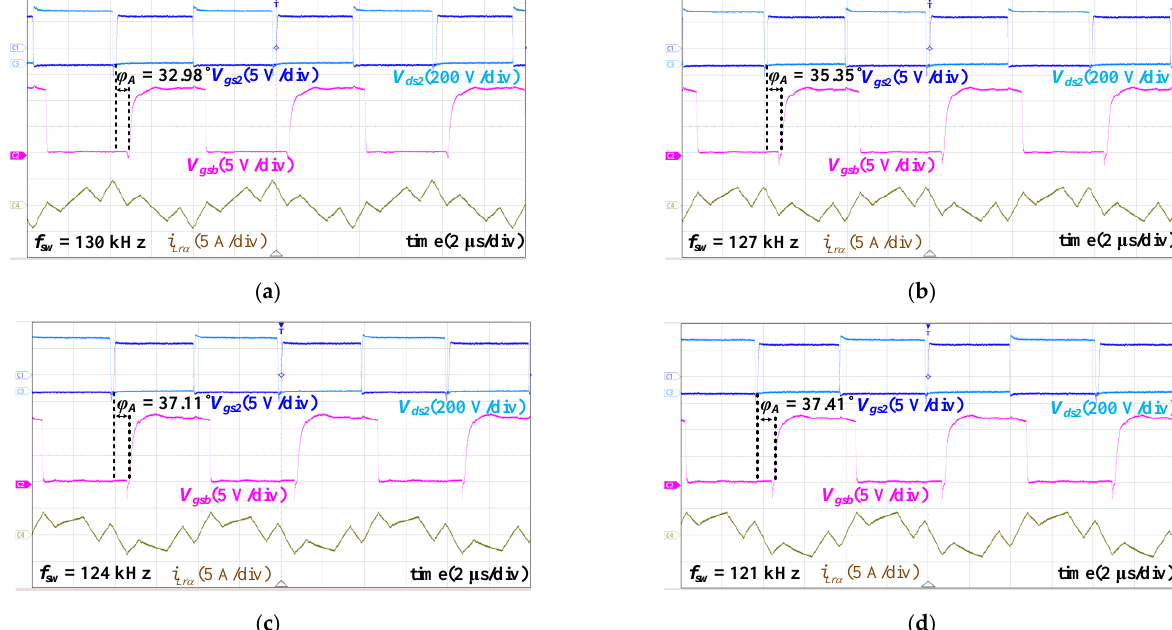
Figure 20. Waveforms of phase shift of the primary- and secondary-sides. Figure 21 shows typical waveforms at a single module. The resonant inductor L rA was equal to 18 μH and had different output load conditions (6.25, 12.5, 18.75 and 25 A). The measured waveforms were the waveforms of V gs 2 and V ds 2 of the primary-side low-bridge switch S 2 , the resonant inductor current i Lrα and the V gsb of the secondary-side switch S b . The values of resonant inductors L rA and L rB were set at different values to test imbal- anced current conditions. L rA was designed as 20 μH and L rB was 16 μH. Figure 22 shows the output current waveforms of the two modules in parallel at a 25% load conduction. Figure 22a,b show without and with a current sharing control. When the function of the current sharing control was disabled, the current was imbalanced due to component mis- match. With a PSM control, the imbalanced current was improved. Both ripple current frequencies of i oA and i oB were six times larger than the switching frequency. Furthermore, with phase lagging φ AB at 30°, the ripple current frequency of i o was twelve times larger than the switching frequency, achieving a minimum output ripple current i o_pp .